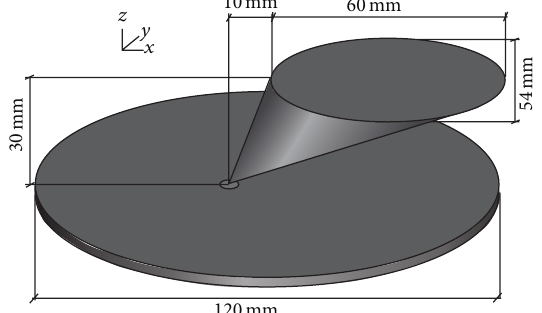
Figure 5: Conical antenna with elliptical aperture displaced of 40 mm.